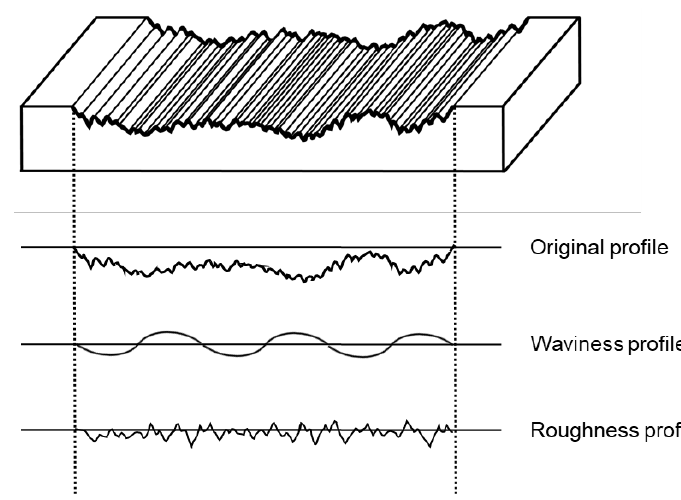
Figure 2. Surface roughness and surface waviness.